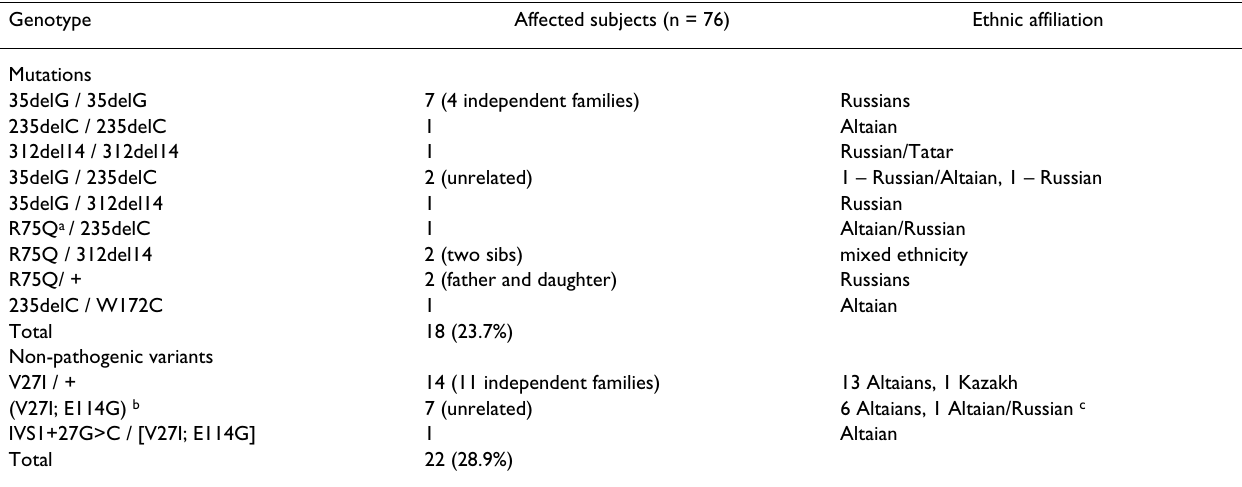
Table 1: GJB2 sequence variations identified in patients